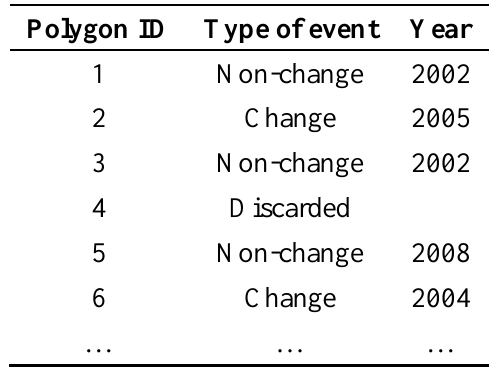
Table 1. SQLite spatial database